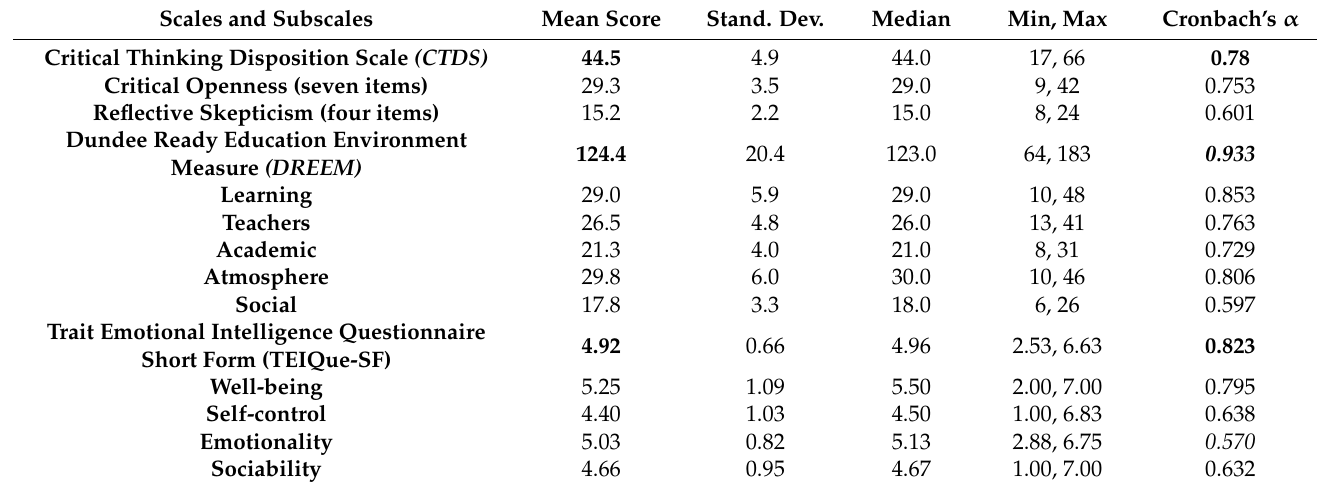
Table 2. Score levels of Critical Thinking Disposition Scale (CTDS), Dundee Ready Education Environ-